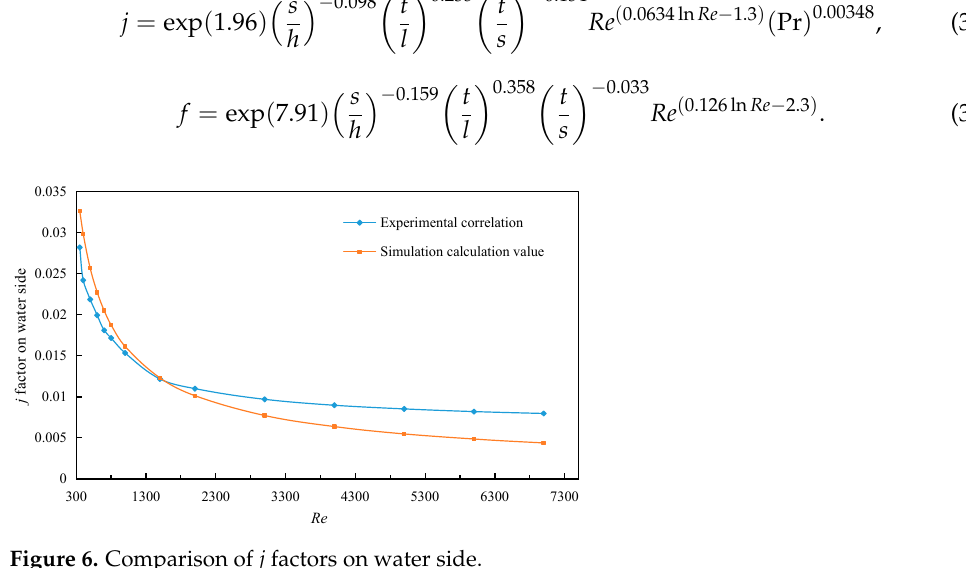
Figure 6. Comparison of j factors on water side.